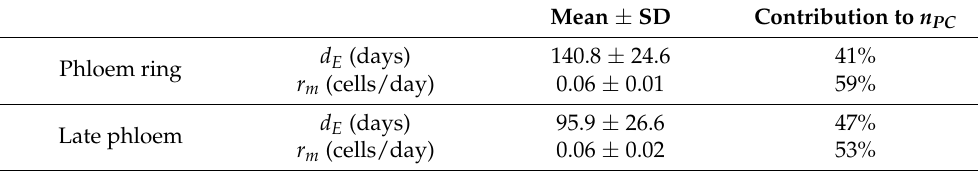
Table 5. Results of sensitivity analysis for the widths of phloem ring, early phloem and late